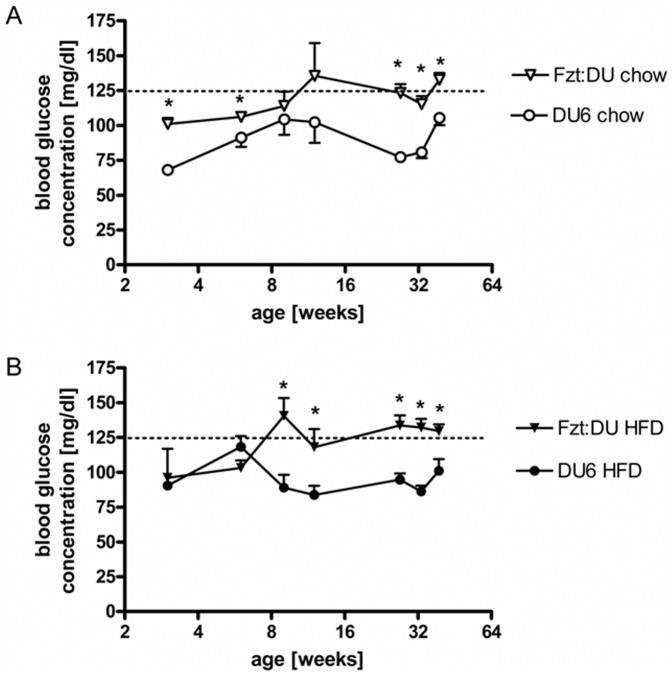
Longitudinal study of fasting glucose levels in male DU6 mice fed chow (A) or a high fat (B) diet (nweek3 = 4; nweek27>13; *: P<0.05).